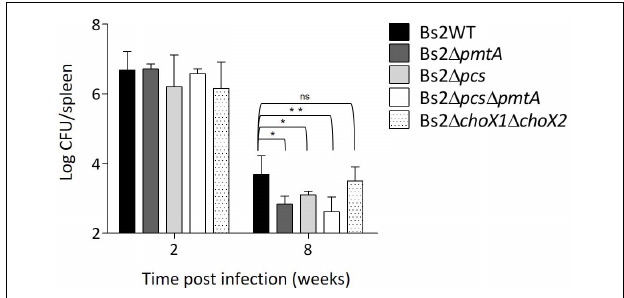
FIGURE 7 | Phosphatidylcholine synthesis is required for Bs2WT full virulence. CFUs in spleen of infected BALB/c mice were counted after intraperitoneal inoculation with 10 5 CFU/mouse of Bs2WT (parental strain), Bs2 (cid:49) pcs , Bs2 (cid:49) pmtA, Bs2 (cid:49) pcs (cid:49) pmtA , or Bs2 (cid:49) choX1 (cid:49) choX2 . * p ≤ 0.05, ** p ≤ 0.01, n.s. not